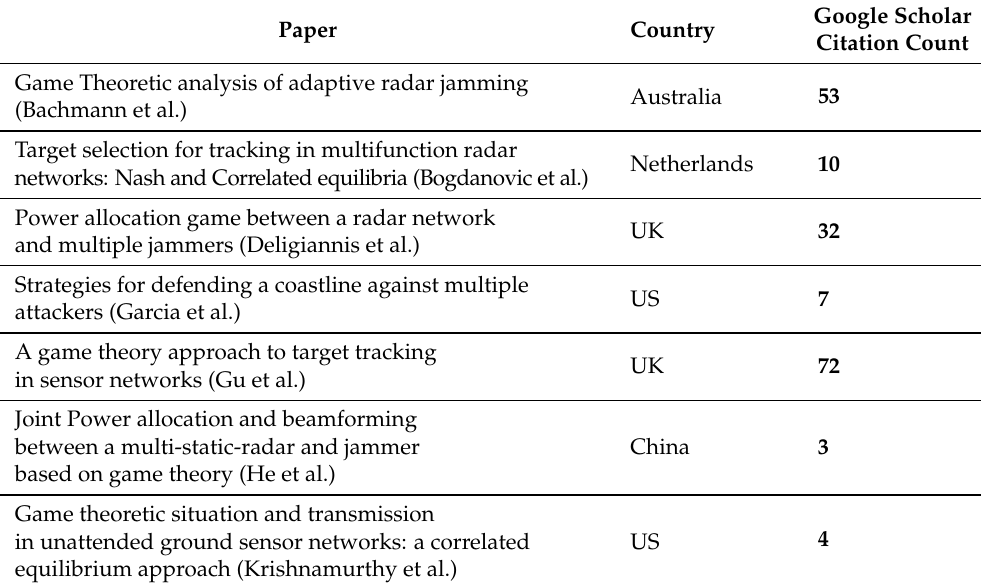
Table 3. Google Scholar citation counts of the reviewed papers. Google Scholar citation data was accessed on 18 December